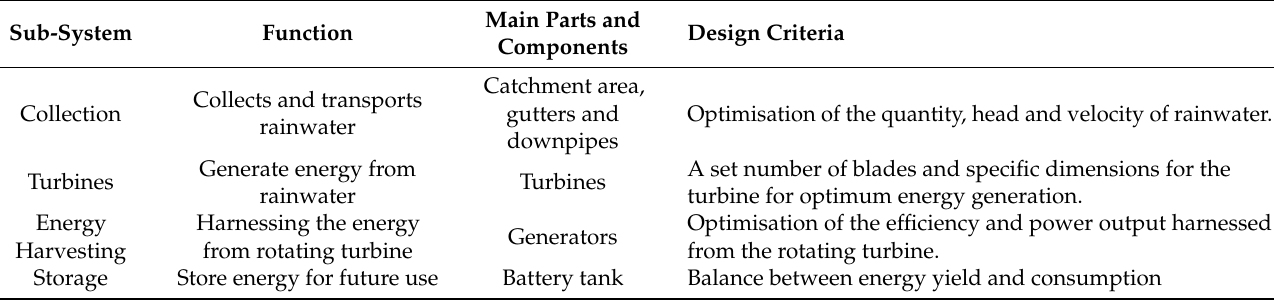
Table 1. Rainwater energy-harvesting